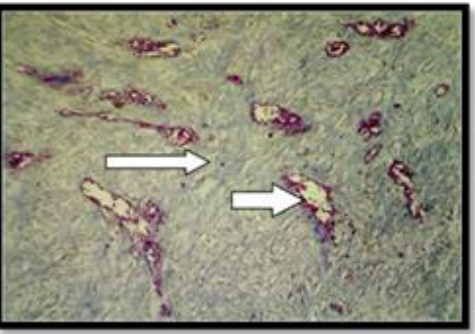
Figure, 12: UBM-treatment group at 2 nd week post implantation, shows formation of granulatin tissue consinsisting from dense collagen fibers (long arrow) with numerous dilated and congested blood vessels (short arrow) with mild MNCs response (Mallory stain,